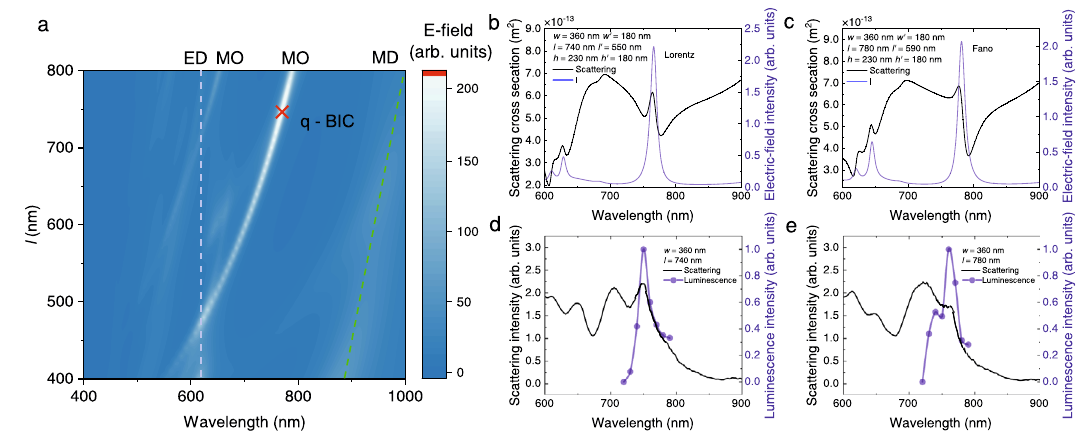
R E j j 4 dV spectra) calculated for Si/SiO 2 cuboids with